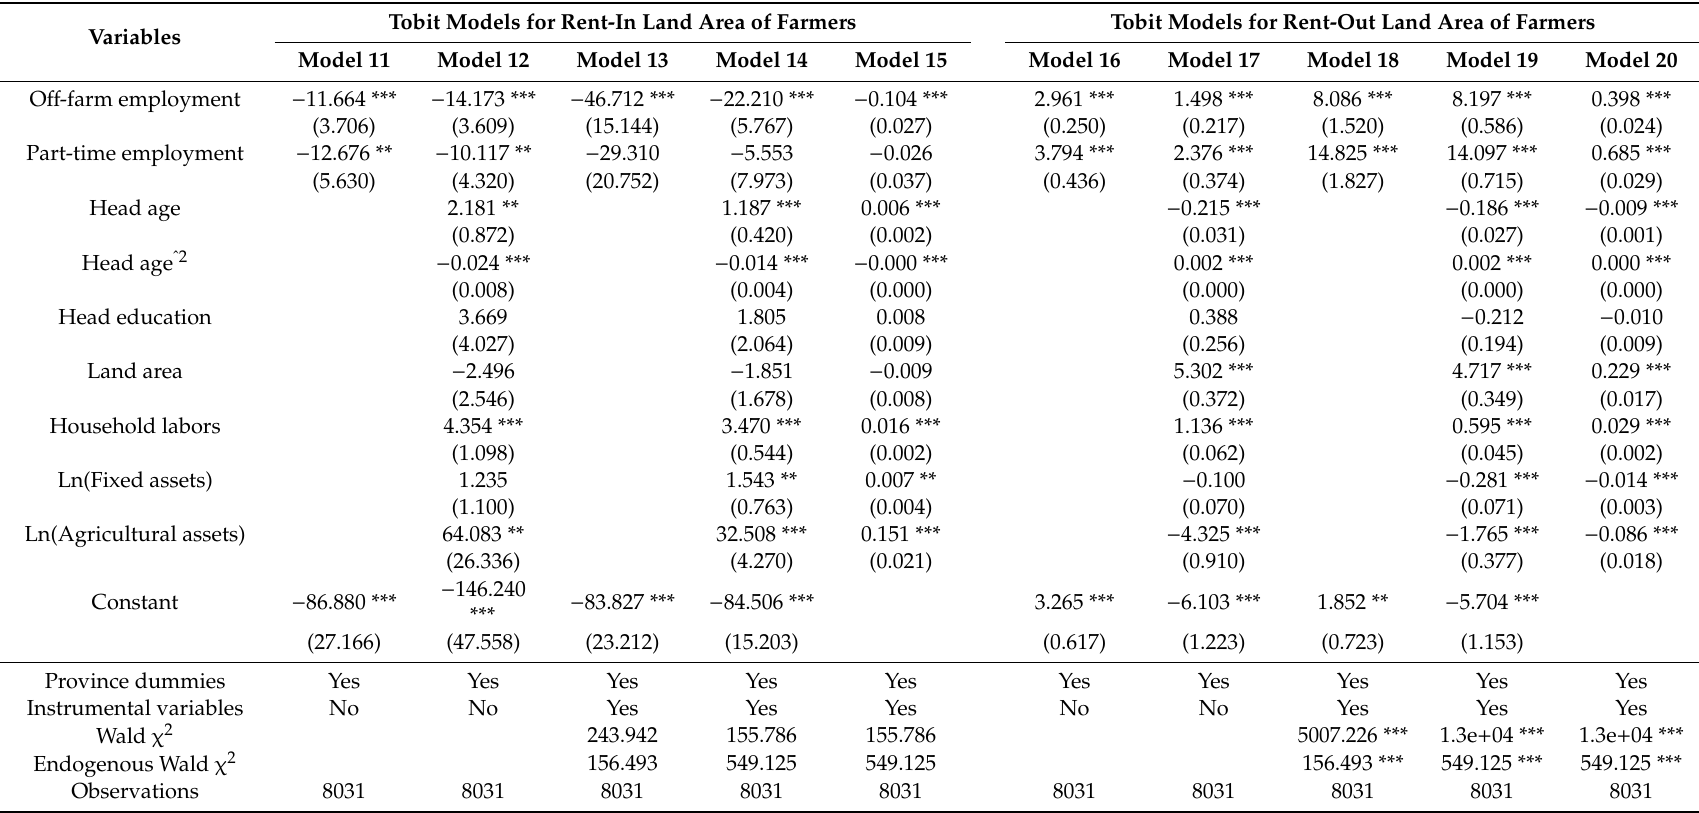
Table 3. Tobit models estimation results of land transfer scale of